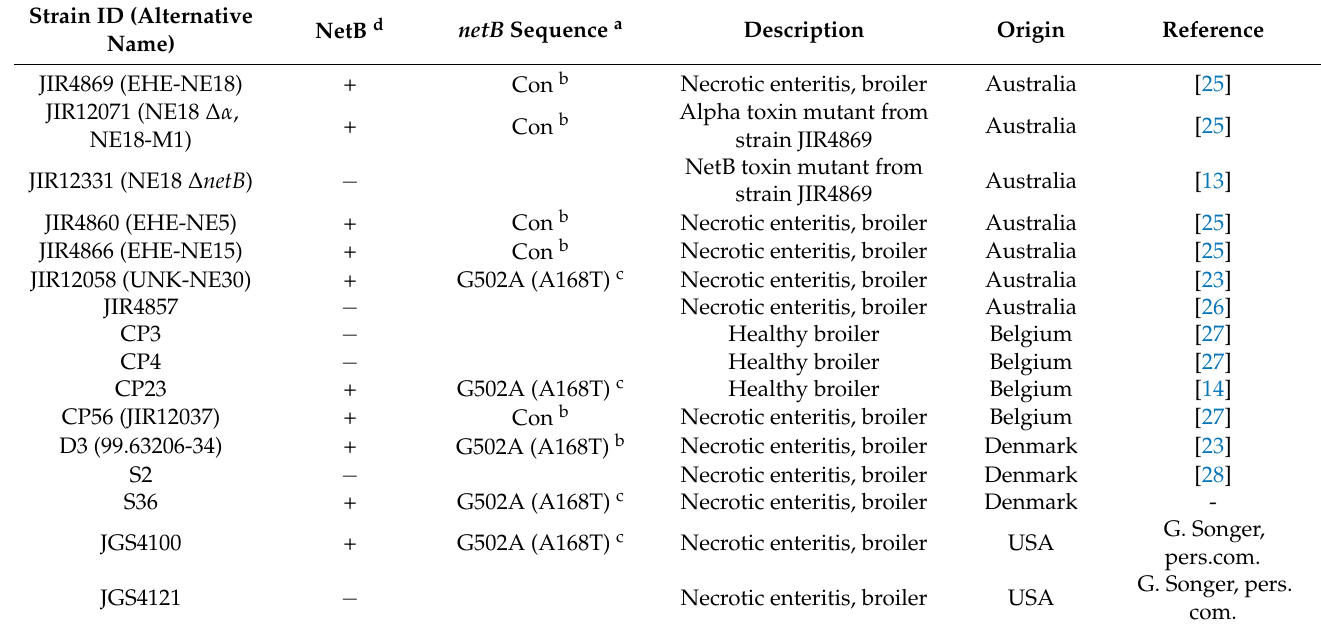
Table 1. C. perfringens strains used in this